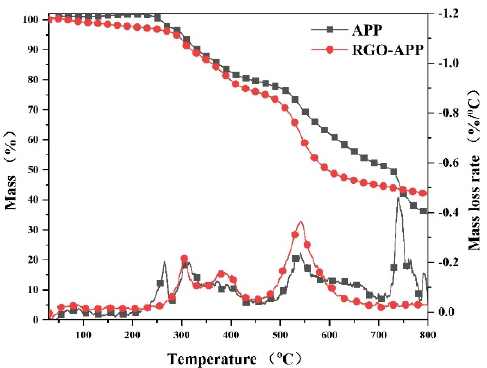
Figure 4. Thermogravimetric test results of APP and RGO-APP.